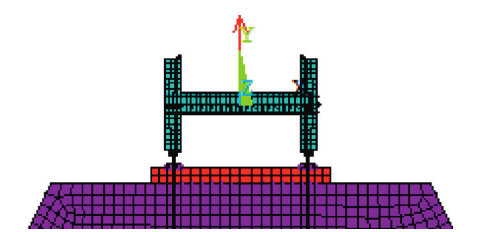
Figure 5: Finite element model for calculation.